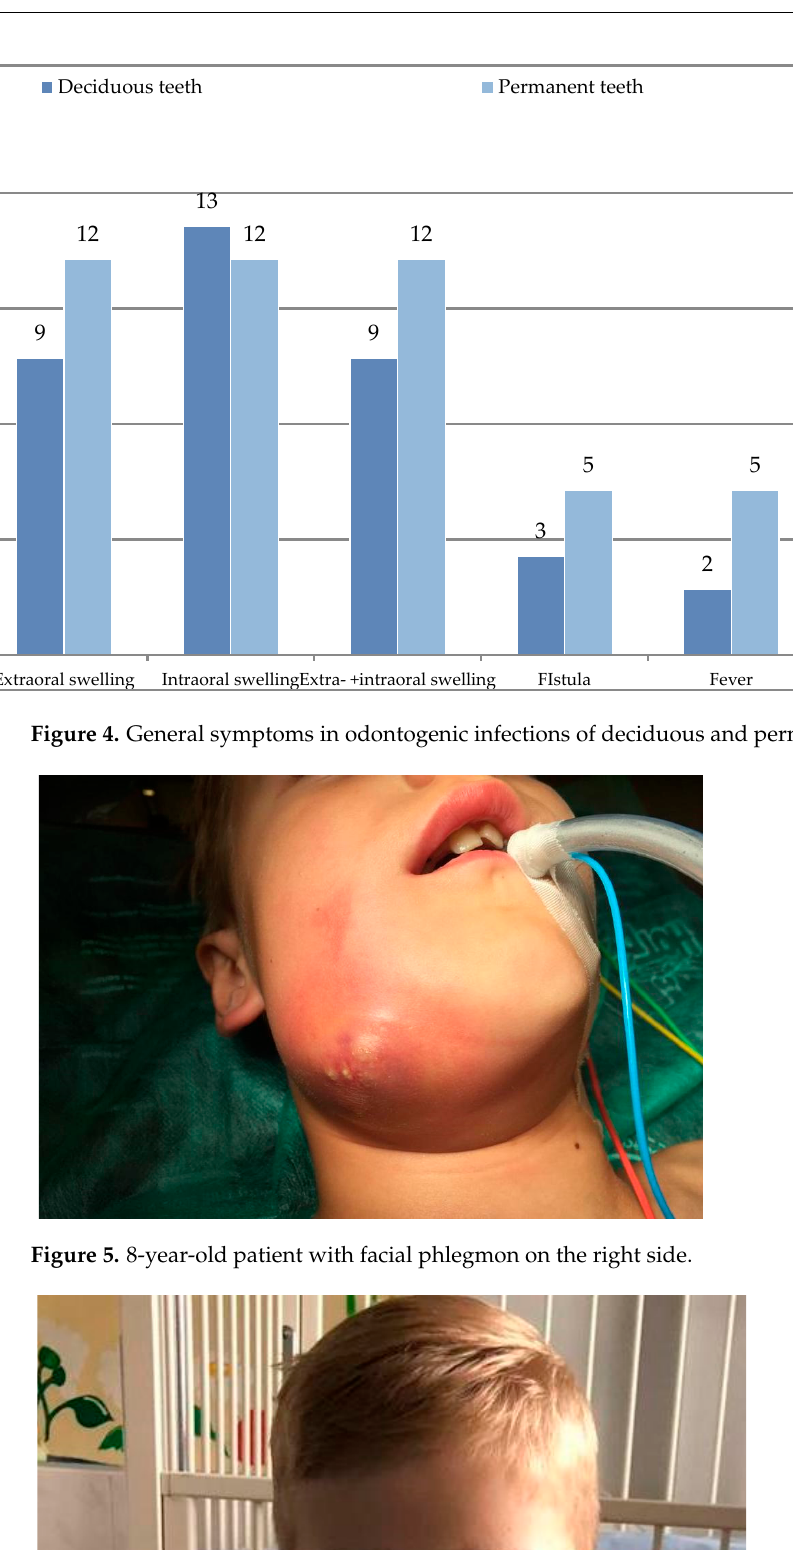
6 of 14 Figure 3. General symptoms in odontogenic infections of the upper and lower face. Table 2. Comparison of odontogenic infections of deciduous and permanent teeth. Study Variables